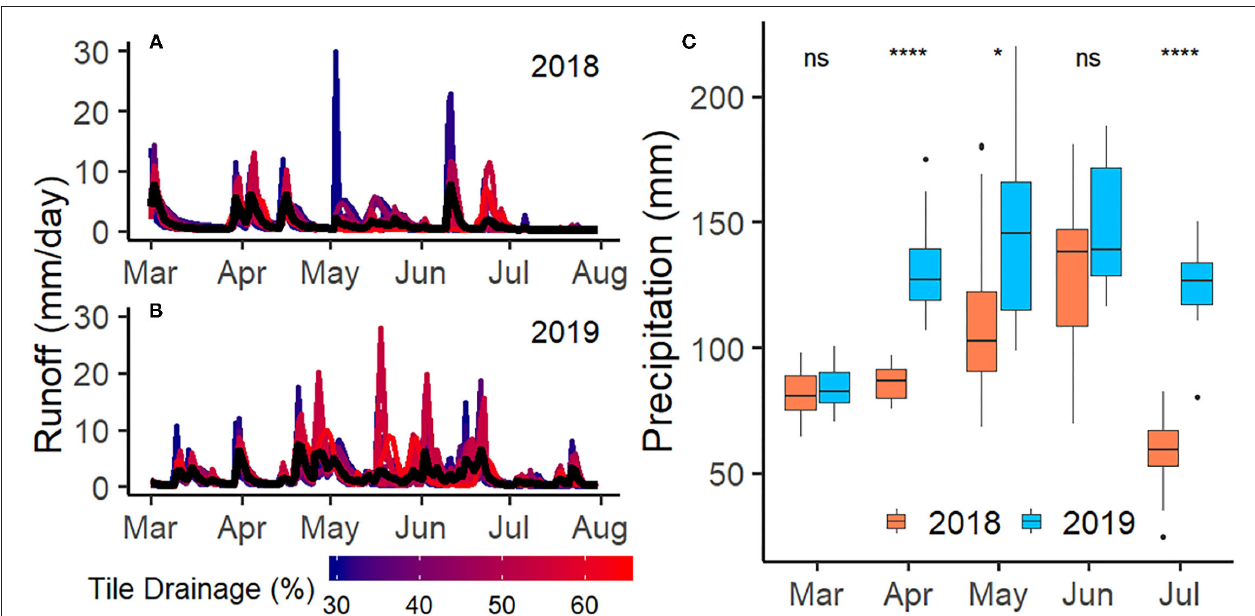
FIGURE 2 | March–July daily runoff in 2018 (A) and 2019 (B) . The color corresponds to the tile drainage percentage for each watershed, while the black line denotes the average daily runoff among the 16 sites. Total monthly precipitation between March and July for 2018 and 2019 (C) . The symbols * and **** indicate p < 0.05 and p < 0.0001 according to the Wilcoxon test, respectively. The letters “ns” indicate non-significant differences ( p >